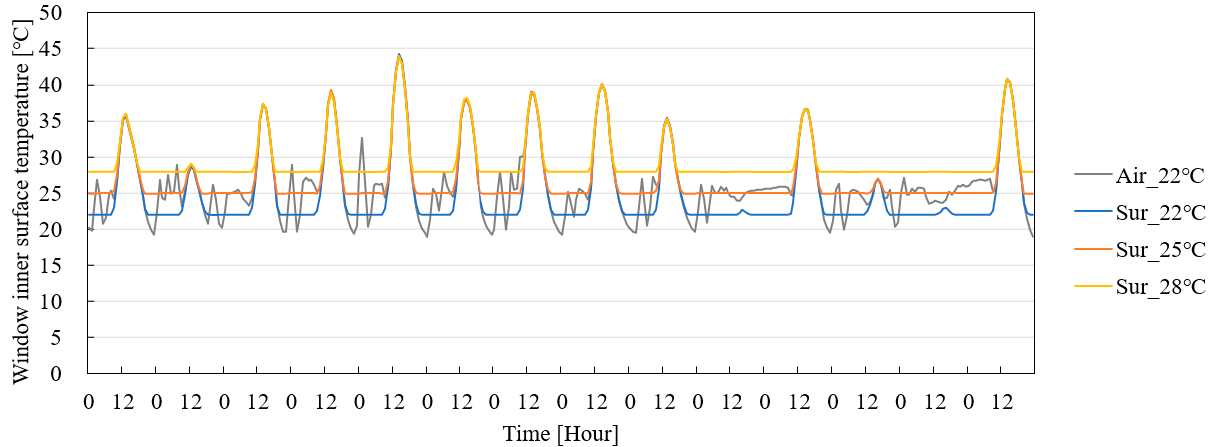
Figure 16. Inner surface temperature of the window.